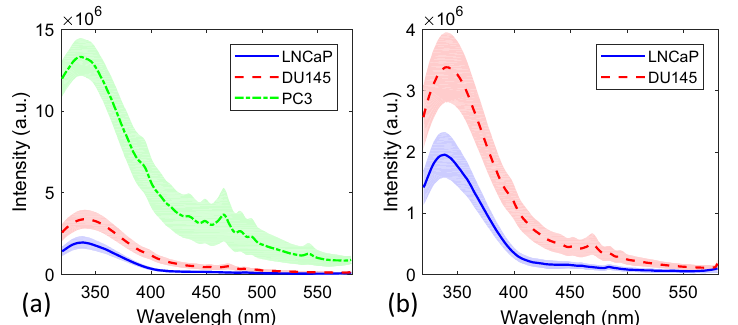
Figure 1. Average and error bounds of raw NFL spectra from ( a ) all three cell lines and ( b ) DU145 and PC-3.